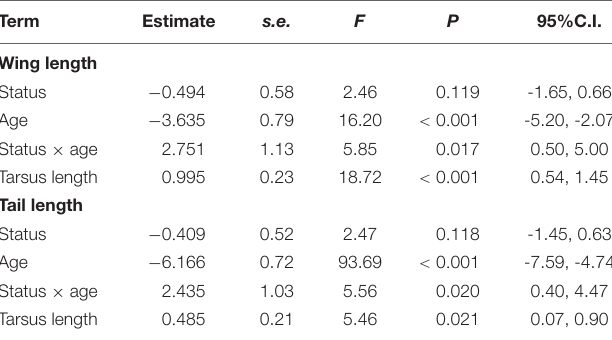
TABLE 2 | Results of LMMs for wing and tail lengths of common kestrel females as a function of dispersal status (immigrant vs. resident), age (young vs. adult), and the interaction between dispersal status and